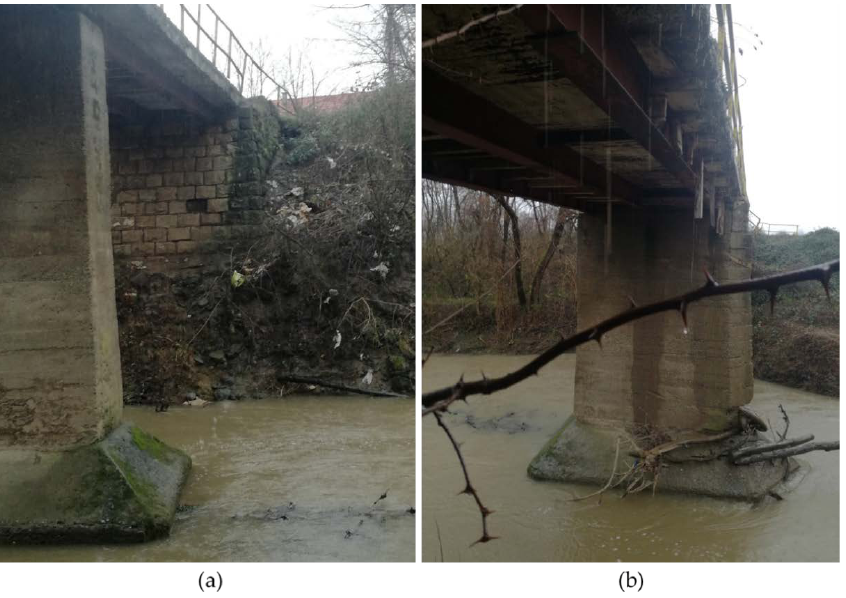
Figure 13. ( a ) Masonry abutment and ( b ) composite superstructure of the bridge to Majske Poljane.